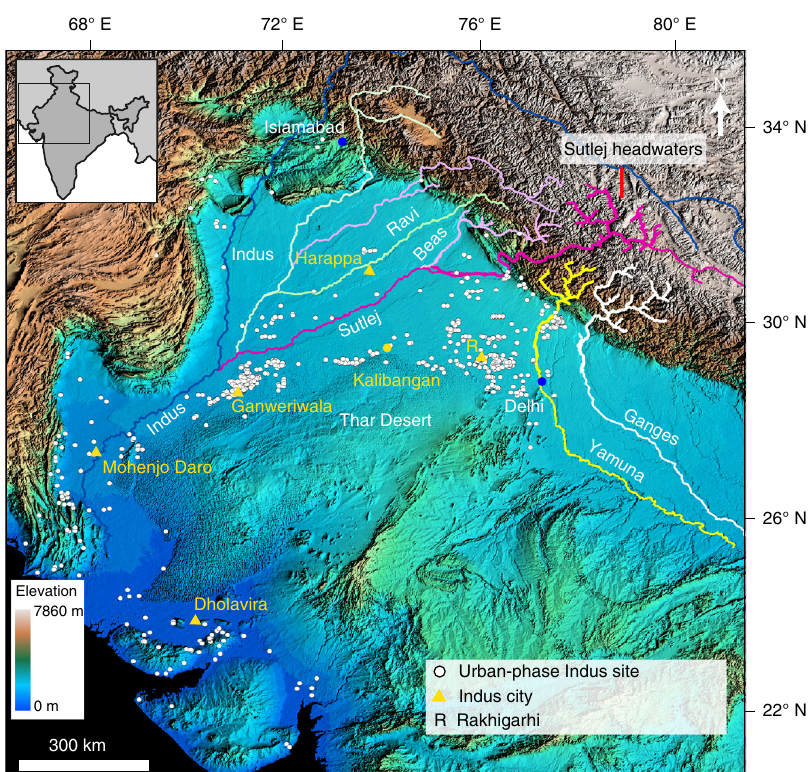
Fig. 1 Topographic map showing northwestern India and Pakistan, key Himalayan rivers and the distribution of urban-phase Indus Civilisation settlements. Note how Indus urban-phase settlements are not necessarily located along modern Himalayan river courses. The most prominent cluster of sites occurs located on the drainage divide between the Sutlej and Yamuna rivers, an area devoid of perennial Himalayan drainage. Base digital elevation map is derived from NASA Shuttle Radar Topography Mission (SRTM) 53 . Site locations are from the compilation of urban-phase Indus settlement locations collated in Possehl 86 . Inset locates fi gure in south